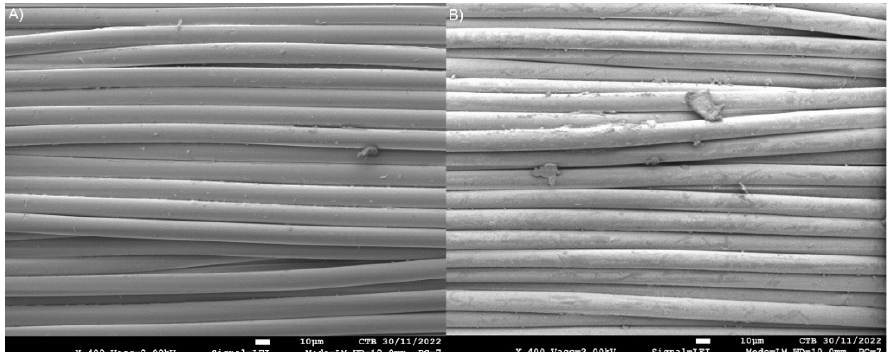
Figure 9. SEM analysis of ( A ) virgin and ( B ) recycled polyester fabric. Table 2. Molecular weight (M n and M w ) and dispersity (Ð) of virgin and recycled